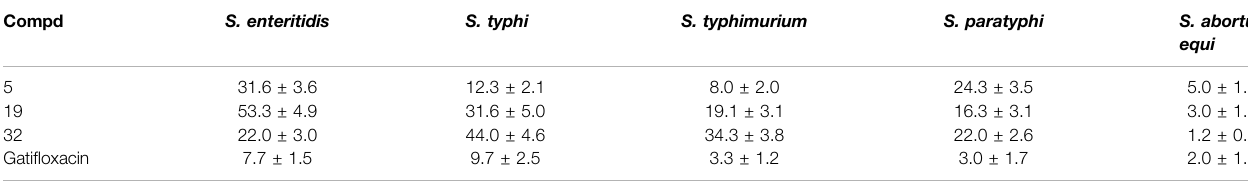
TABLE 2 | Inhibitory activity (MICs in μ g/mL) of compounds 5, 19, and 32 against Salmonella sp. Compd